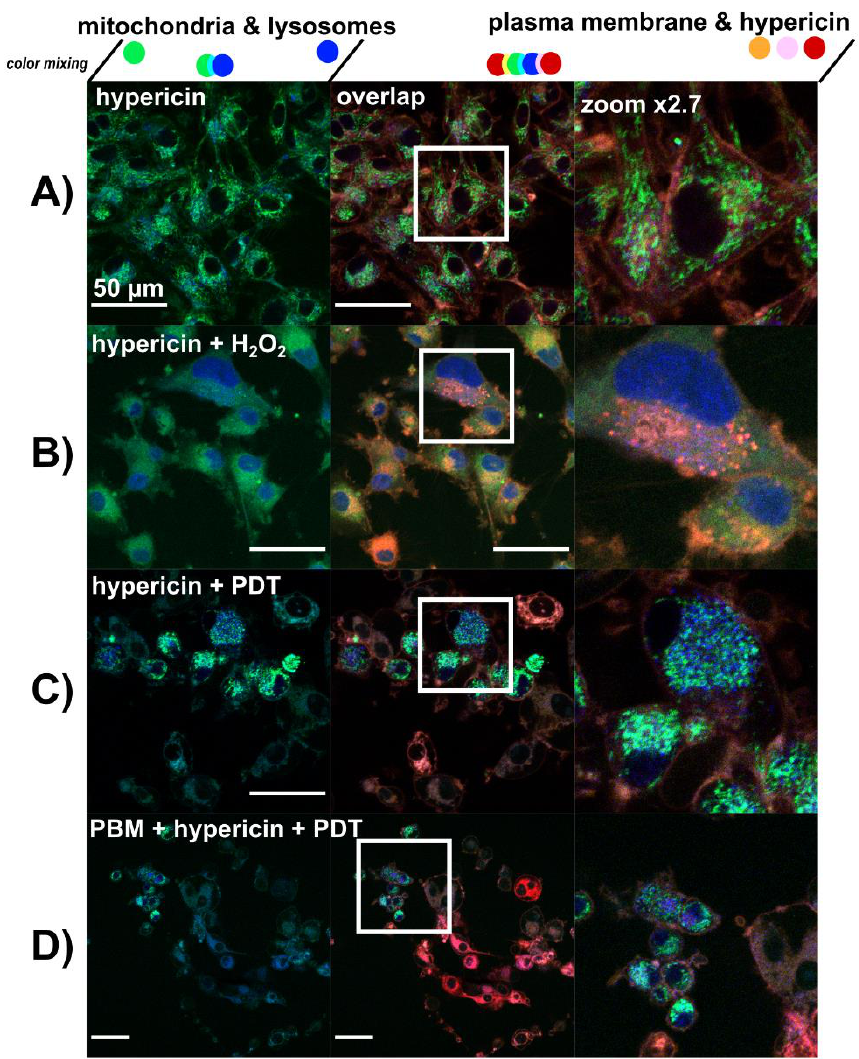
Figure 5. Confocal fluorescence images of rhodamine 123—mitochondria (green), LysoTracker Blue—lysosomes (blue), hypericin (orange and red) and Cell Mask Orange—plasma membrane (orange and red) in ( A ) U87 MG cells treated with 500 nM hypericin for 3 h, ( B ) hypericin in A + 1 mM H 2 O 2 for 10 min, ( C ) hypericin-PDT and ( D ) PBM-hypericin-PDT detected 5 h after PDT. Overlapping images were magnified to better identify the organelles detected. Scale bar—50 µm.